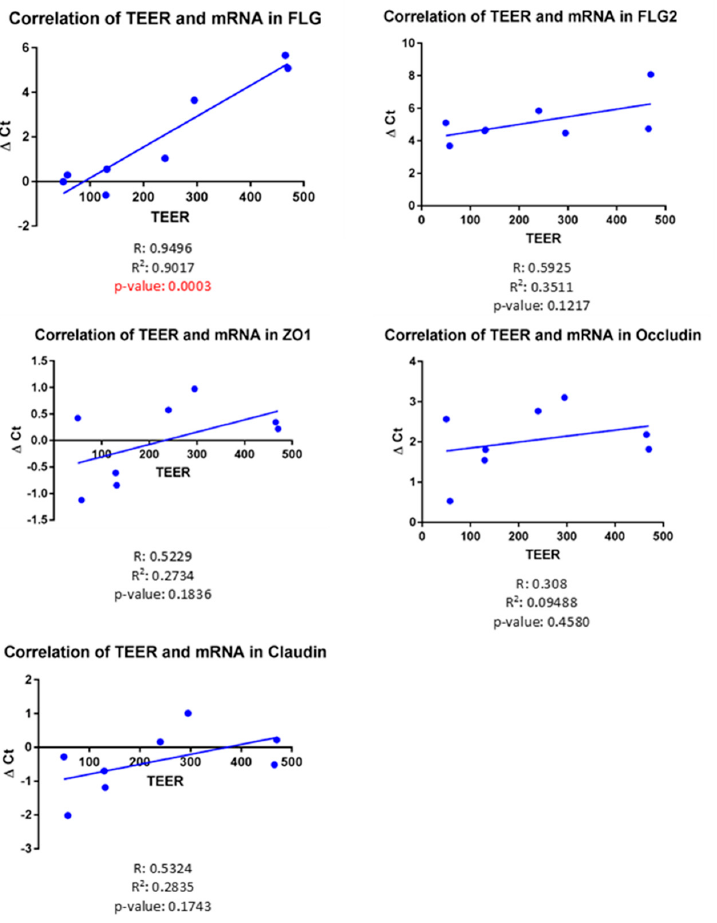
Figure 3. Correlation between TEER and the gene expression of filaggrins and TJ proteins on D6. The only statistically significant correlation was found between gene expression of filaggrin and TEER (r = 0.95, p = 0.0003), combining both normal and atopic samples.